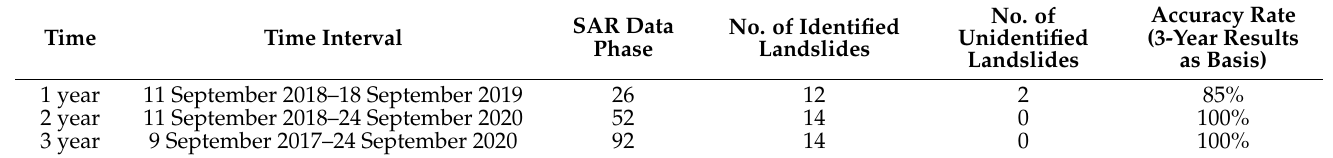
Figure 16. Comparison of deformation rate map and the identification results of different monitoring periods based on SBAS InSAR technology. ( a ) The monitoring period is one year; ( b ) the monitoring period is two years; ( c ) the monitoring period is three years. Table 2. Statistics of identification results of potential landslides using SAR data with different time periods (Danba